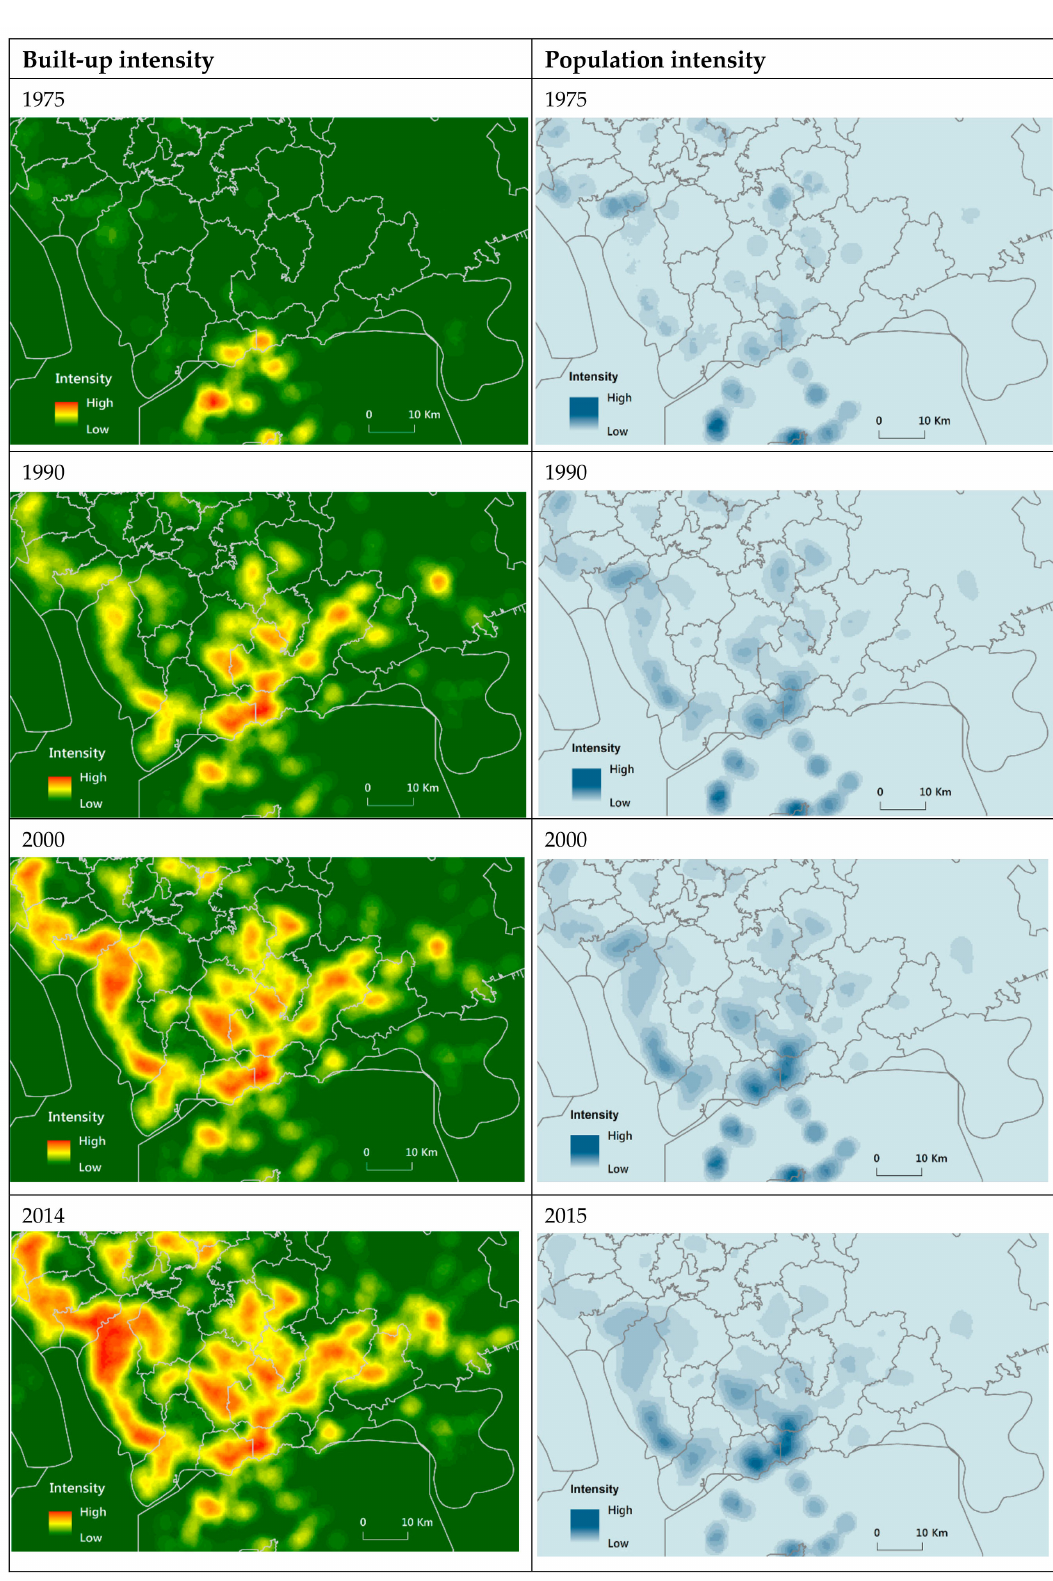
Figure 4. Maps of built-up and population intensity in Shenzhen in the years 1975, 1990, 2000 and 2014/2015. (Source: Own calculation and visualisation based on GHSL data © EC,